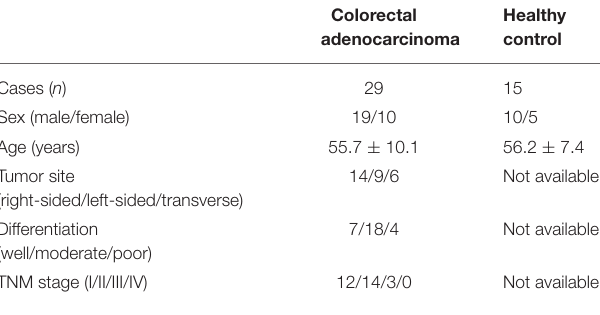
TABLE 1 | Clinical characteristics of enrolled